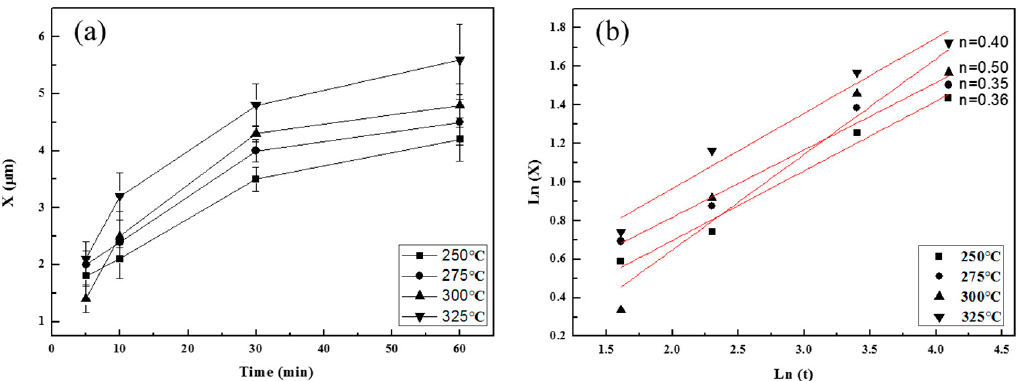
Figure 7. Thickness ( X ) of Ni 3 Sn 4 intermetallic compound formed during diffusion soldering of Bi 2 Te 2.55 Se 0.45 thermoelectric material with Cu electrode using Sn interlayers: ( a ) X versus t , ( b ) Ln X versus Ln t .